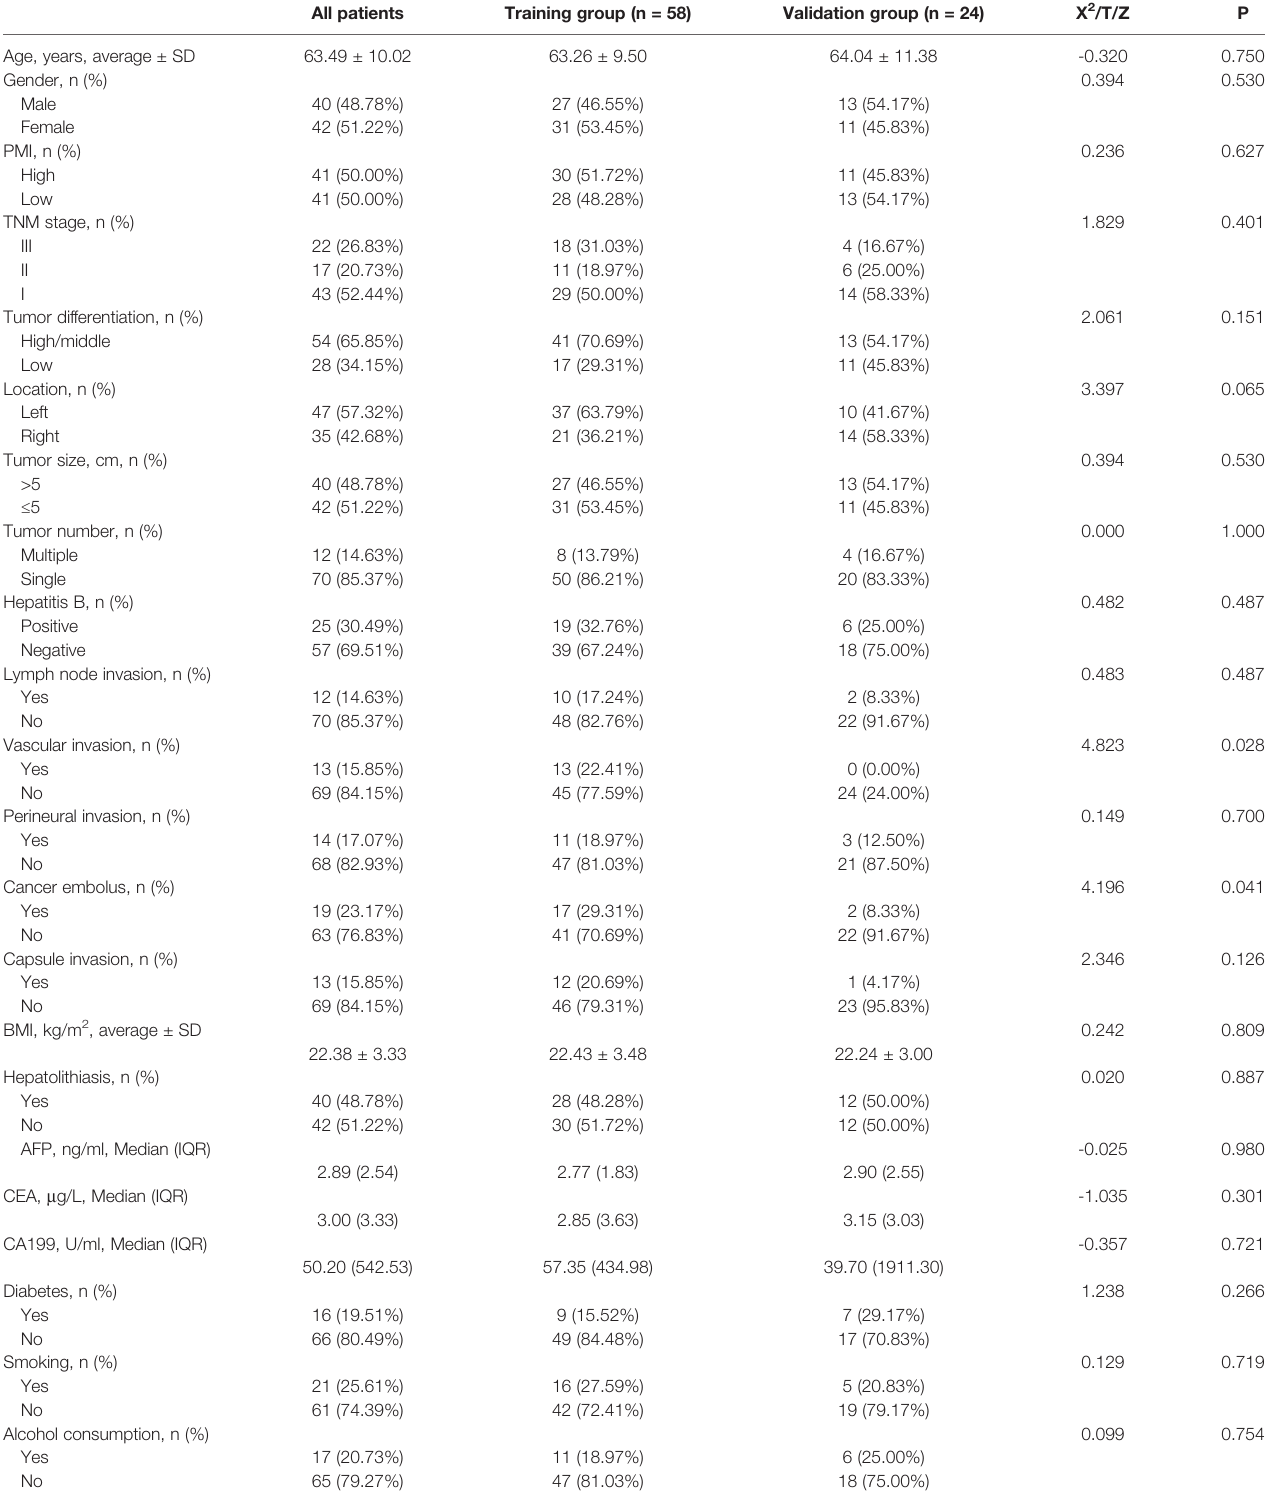
TABLE 1 | Demographic and clinicopathological characteristics of ICC